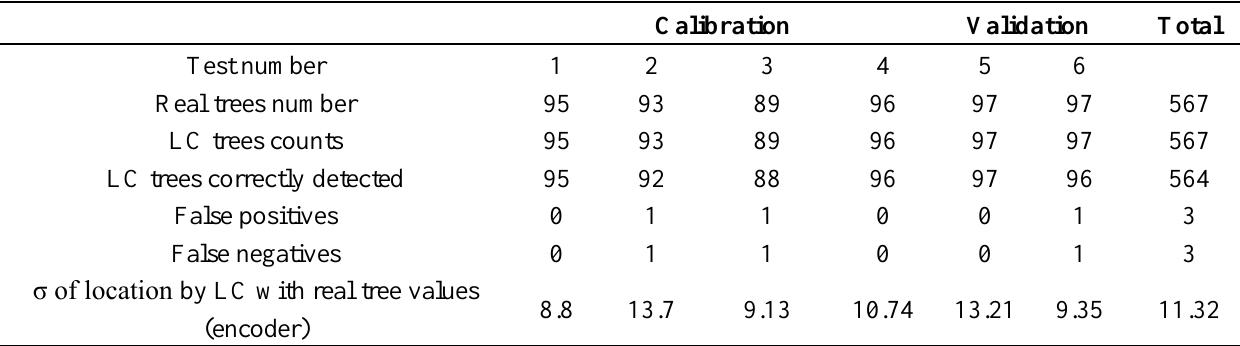
Table 11. Light curtain results obtained for the calibration and validation samples using the parameter values selected after independent evaluations (tree encoder of 13 and minimal tree distance of 130).